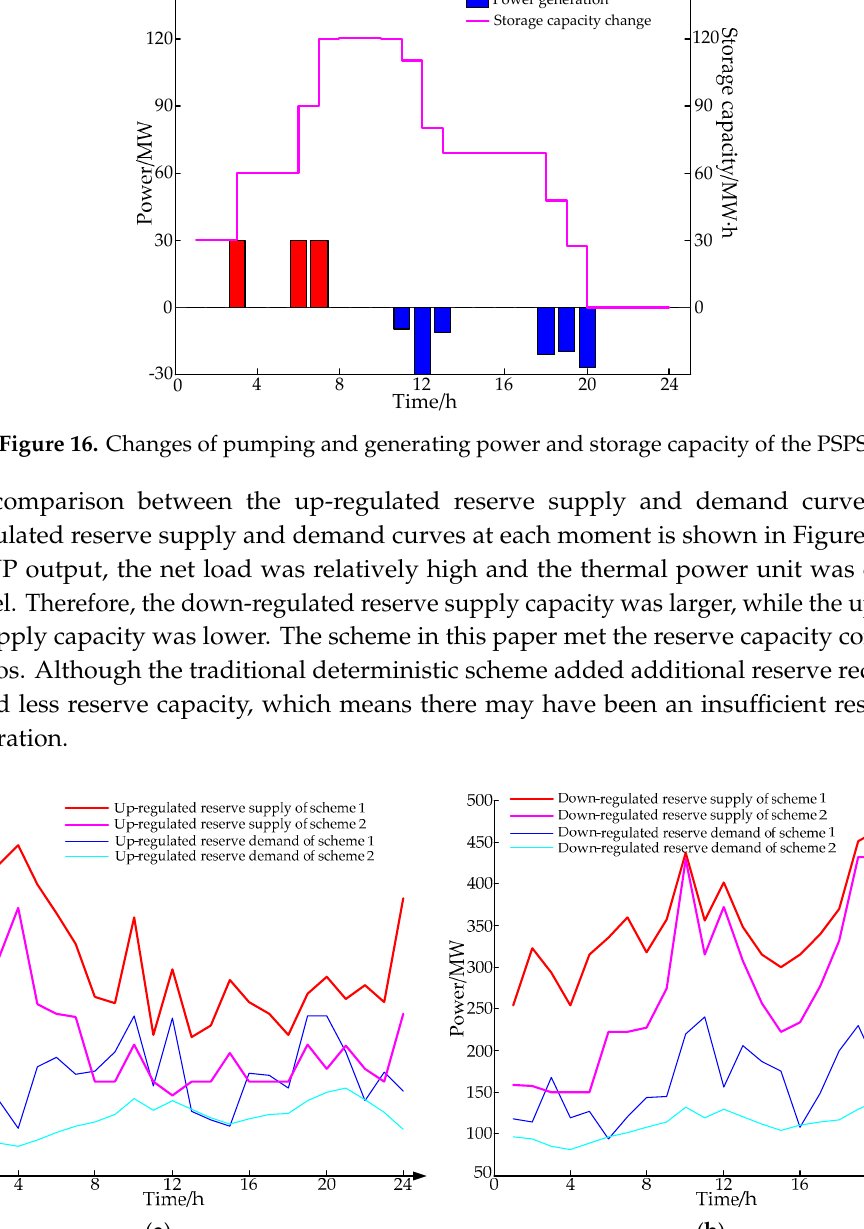
Figure 15. Output of each power source under wind power continuous low output condition.